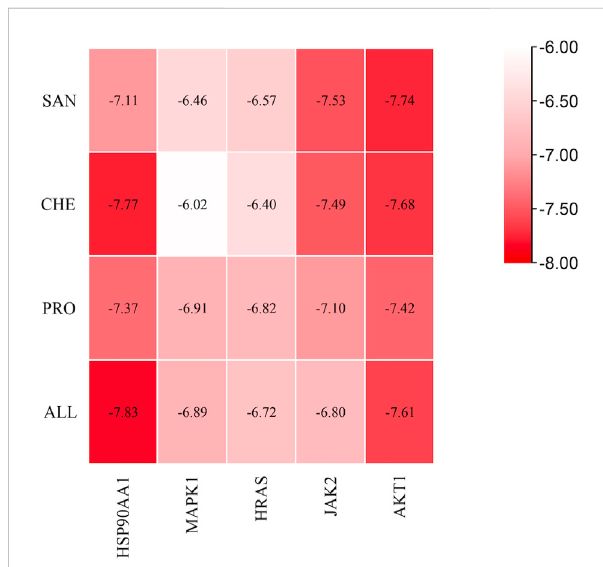
FIGURE 6 Heatmap of the molecular docking results between active compounds and core targets. The vertical coordinates represent the four active compounds of MCE, the horizontal coordinates represent the core targets, and the colors from red to white indicate the strongest to weakest binding